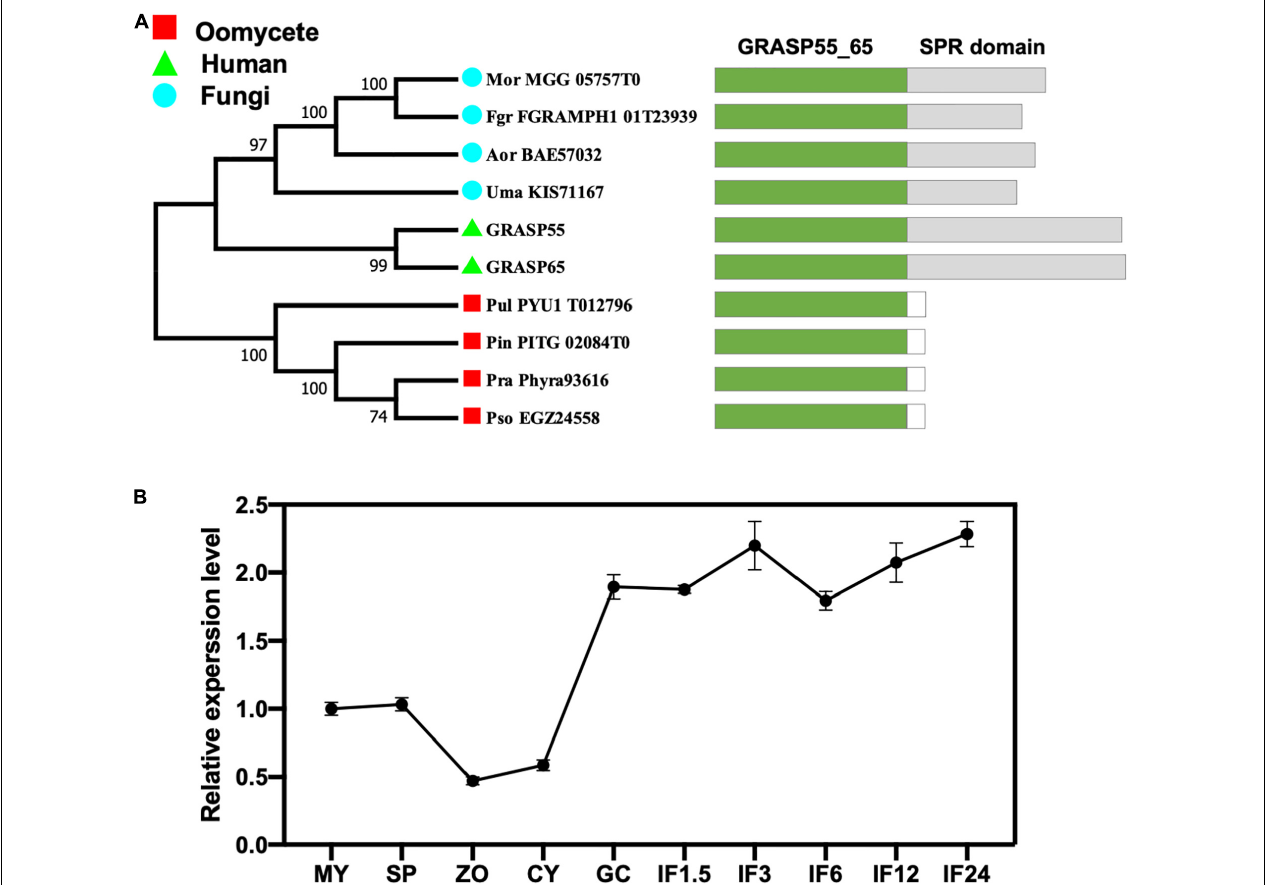
FIGURE 1 | Identification of the GRASP protein (PsGRASP) in P. sojae . (A) The phylogenetic tree of ten predicted GRASPs from human, fungi, and oomycetes. They all have the conserved GRASP55_65 domain with the SPR domain missing in oomycete GRASPs. The phylogenetic tree was constructed with MEGA X using the maximum-likelihood method. Thousand bootstrap replicates were performed. Colored rectangles in the schematic diagrams of protein structures represent the different domains in each protein. (B) The transcript accumulation profile of PsGRASP in P. sojae life cycle and the infection stages, which was determined by qRT-PCR using RNAs extracted from vegetative mycelia (MY), sporangia (SP), zoospores (ZO), cysts (CY), germinated cysts (GC), and samples of different infection stages (IF 1.5, 3, 6, 12, and 24 refer to materials taken after the respective hours of inoculating hyphae on soybean leaves). Relative PsGRASP expression levels were calculated using the MY values as a